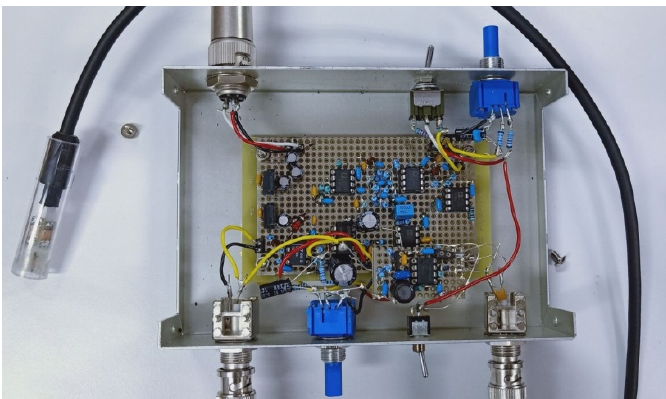
Figure 8. FeCoSiB amorphous wire magnetic sensor and the driving circuit.